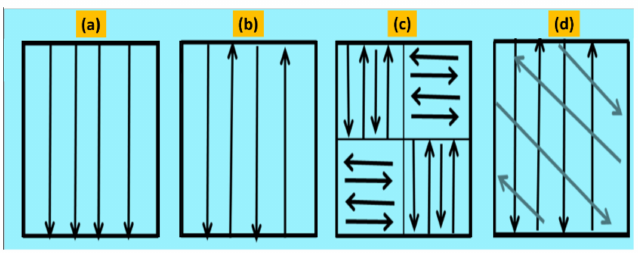
Figure 8. Various scan patterns used in SLM: ( a ) unidirectional, ( b ) bi-directional (zig-zag), ( c ) angularly adjusted from section to section, and ( d ) different rotation angles between consecutive